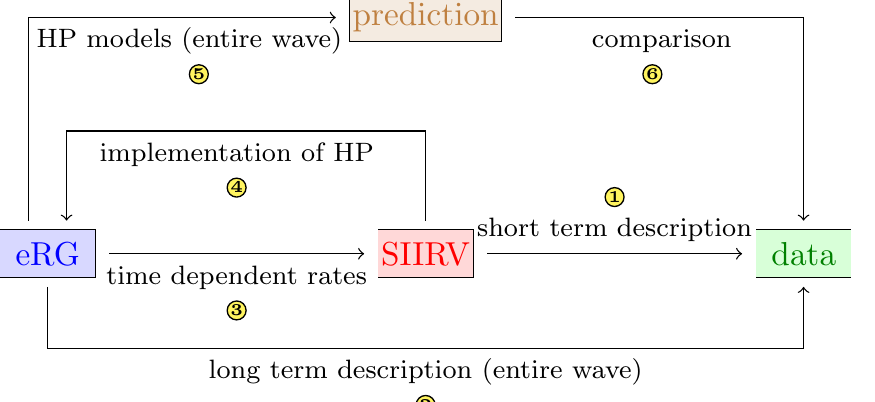
Figure 1. Schematic overview of the interplay between a compartmental model (SIIRV) and an eRG approach to arrive at quantitive prediction on HP measures from input